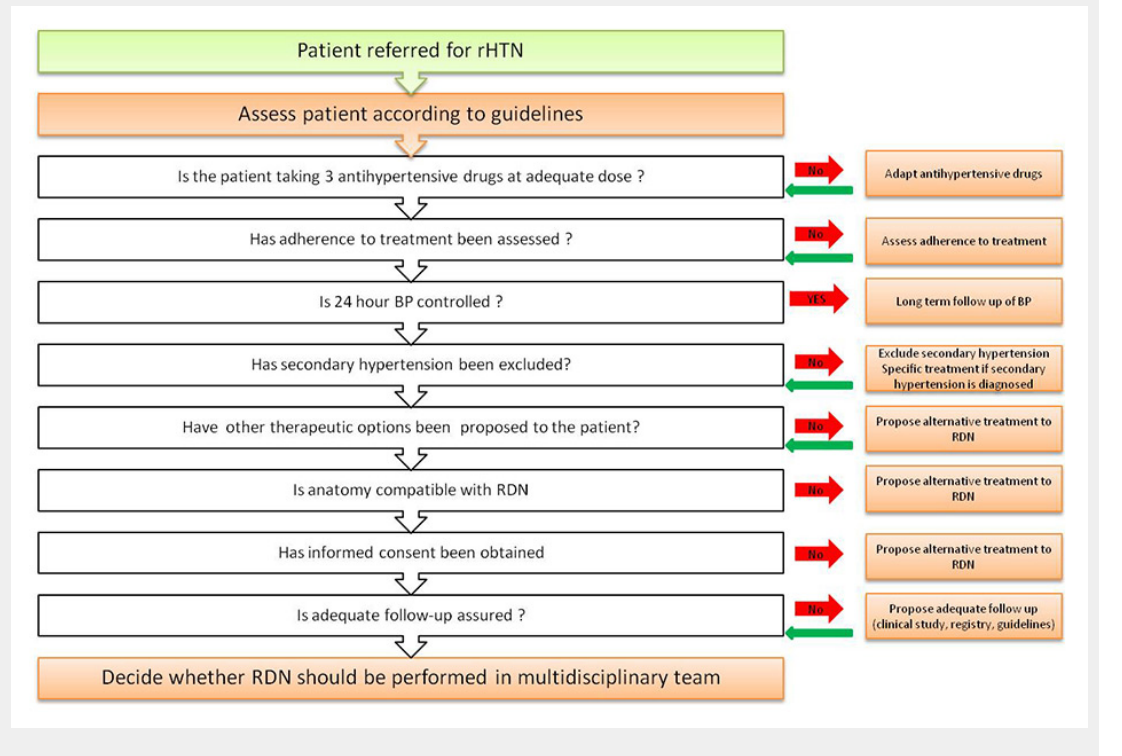
Figure 1 Suggested algorithm for the work-up before endovascular renal denervation (RDN) in resistant hypertension